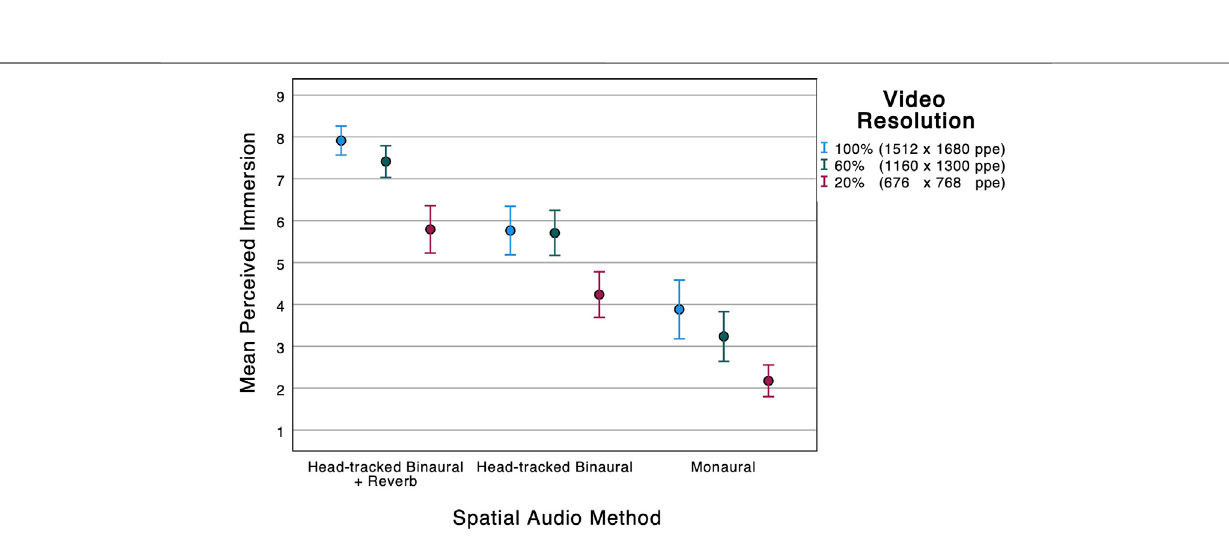
Frontiers in Signal Processing |